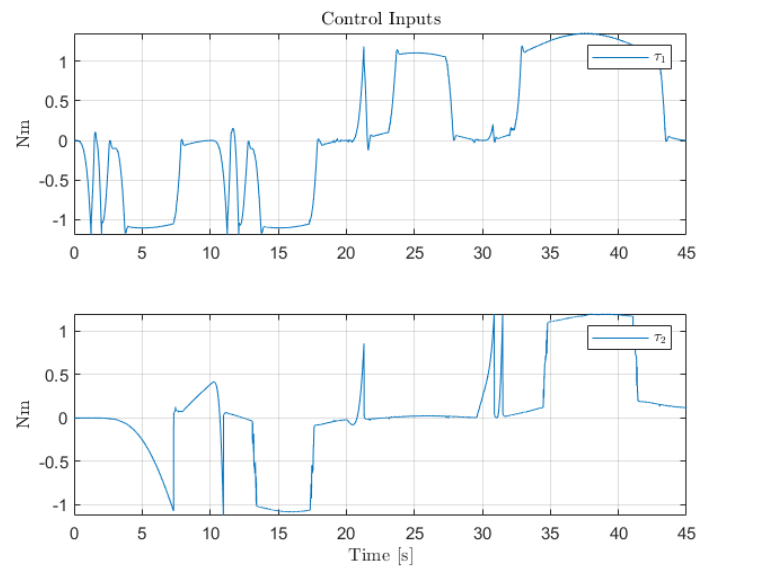
Figure 14. Control inputs for the servo-actuators of Links 1 and 2.